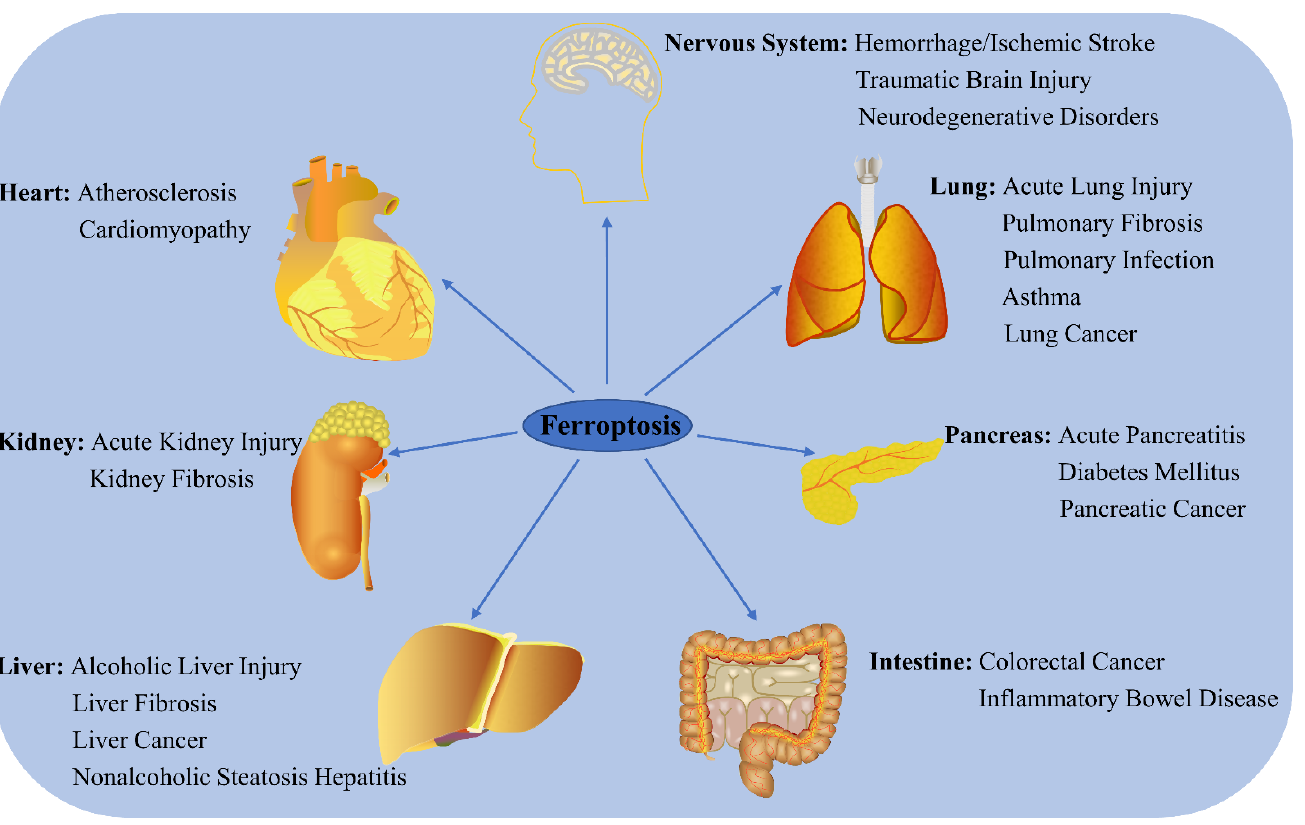
Figure 2. Role of ferroptosis in chronic diseases. Ferroptosis participates in the regulation of many system disorders, including nervous system diseases, cardiovascular diseases, liver diseases, kidney diseases, lung diseases, pancreatic diseases, and intestinal diseases.